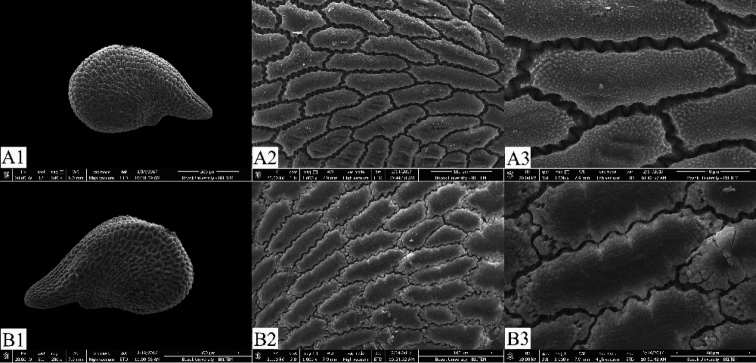
SEM photographs of the seed coat. APhrynaortegioidesBP.hamzaoglui. Scale bars: 500 μm (A1, B1); 100 μm (A2, B2); 40 μm (A3, B3).